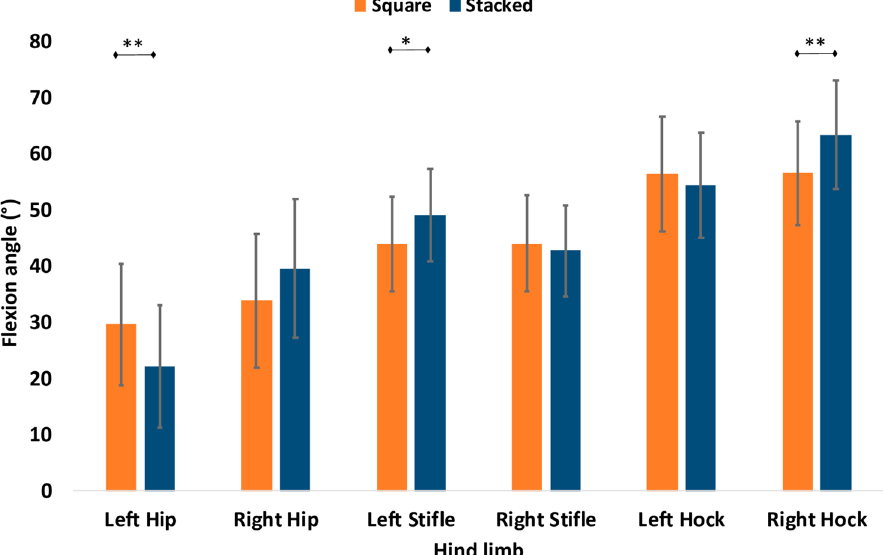
Figure 6. The flexion angle of the hindlimb joints when the GSD stands square and in the stacking position with the left hindlimb retracted, showing the mean and standard variation for the 60 GSDs. Significant differences are indicated using *For p < 0.05, **for p < 0.01, **For p <